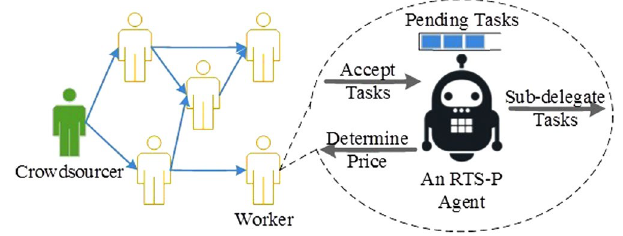
Figure 1. An RTS-P agent in an